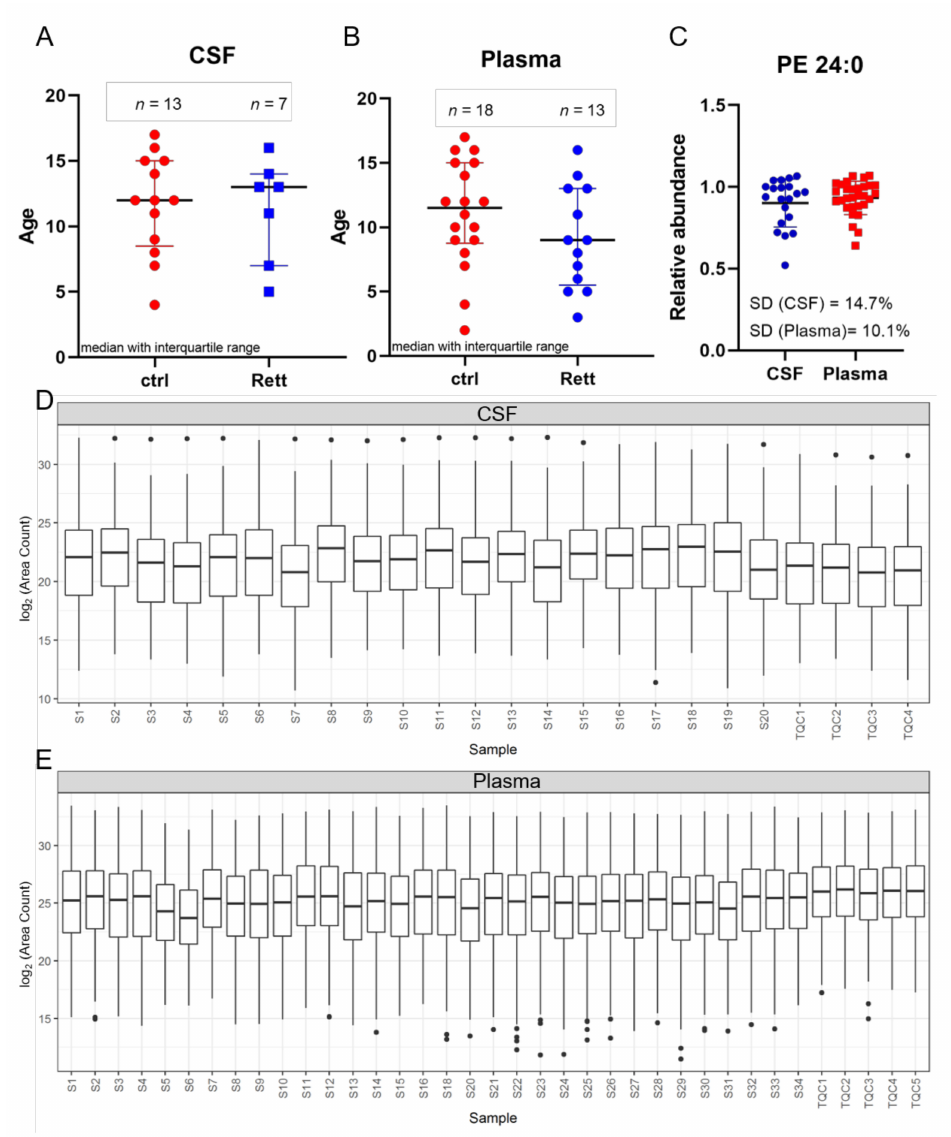
Figure 1. Age distribution and quality control. Demographic information and median age on the study subjects (( A ) for CSF; ( B ) for plasma) ( C ) Phosphatidylethanolamine (PE) 24:0 as extraction control for sample preparation and UHPLC-MS/MS analysis. Standard deviation (SD) for CSF is 14.7% and for plasma samples 10.1%. ( D , E ) Overview of all CSF ( C ) and plasma ( D ) samples